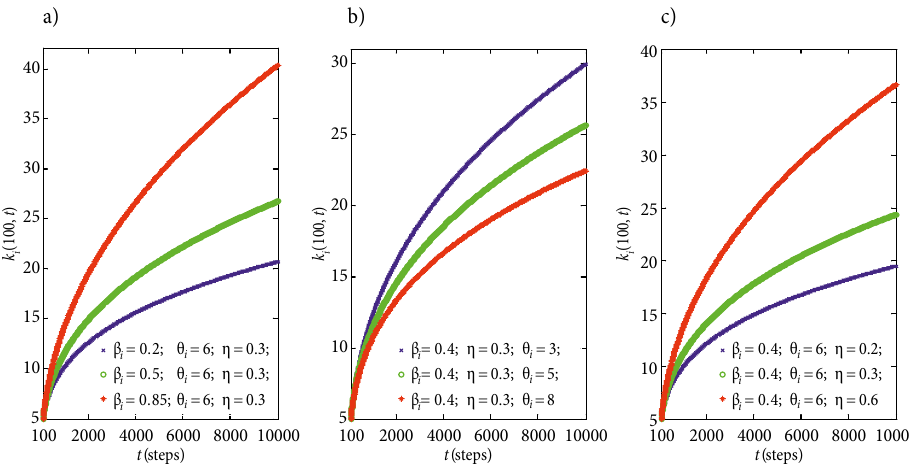
100 2000 4000 6000 8000 Fig. 3. The evolution of the infected path of a node infected at time j = 100 in the network of credit risk contagion in logarithmic scales. (a) The effect of the risk aversion sentiments b infected path at q = 6 and h = 0.3. (b) The effect of the resistance q i i at b = 0.4 and h = 0.3. (c) The effect of the average fitness h of credit risk contagion on its infected i i path at b = 0.4 and q = 6. The continuous curve is according to the analytical result of Eq. (13) i i